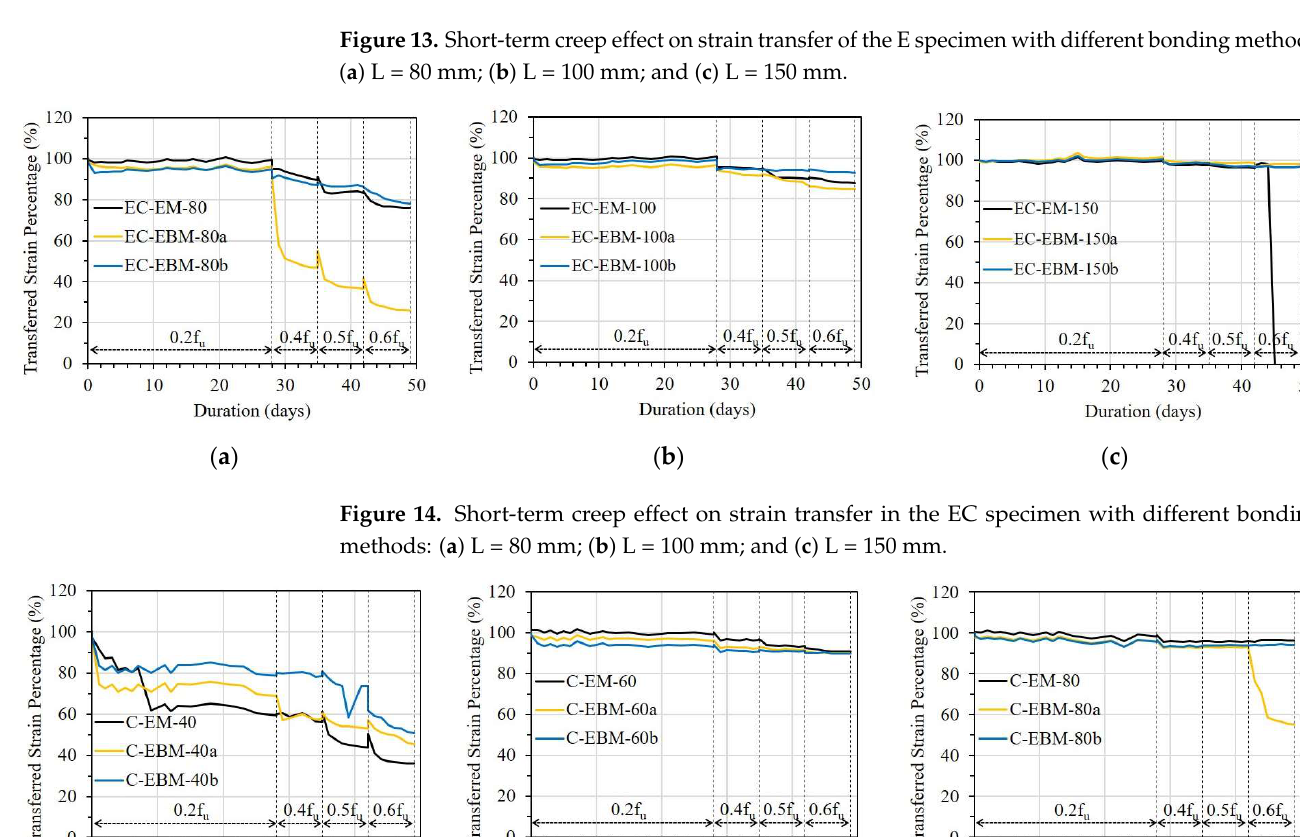
Figure 13. Short-term creep effect on strain transfer of the E specimen with different bonding methods: ( a ) L = 80 mm; ( b ) L = 100 mm; and ( c ) L = 150 mm.